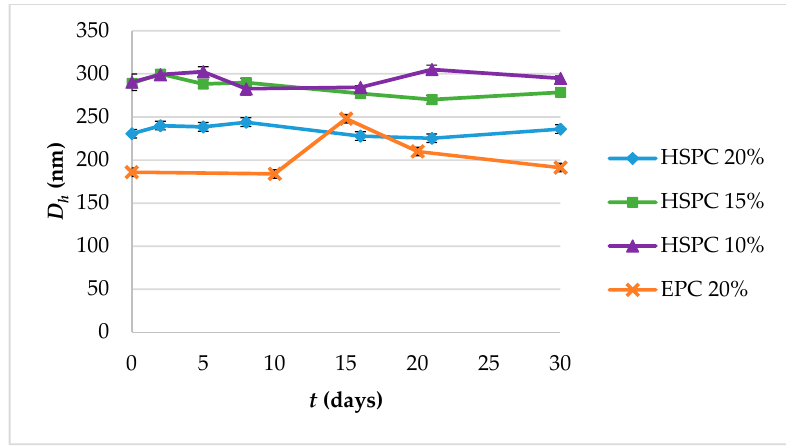
Figure 3. Colloidal stability diagram in terms of particle size (hydrodynamic diameter, D h ) and of